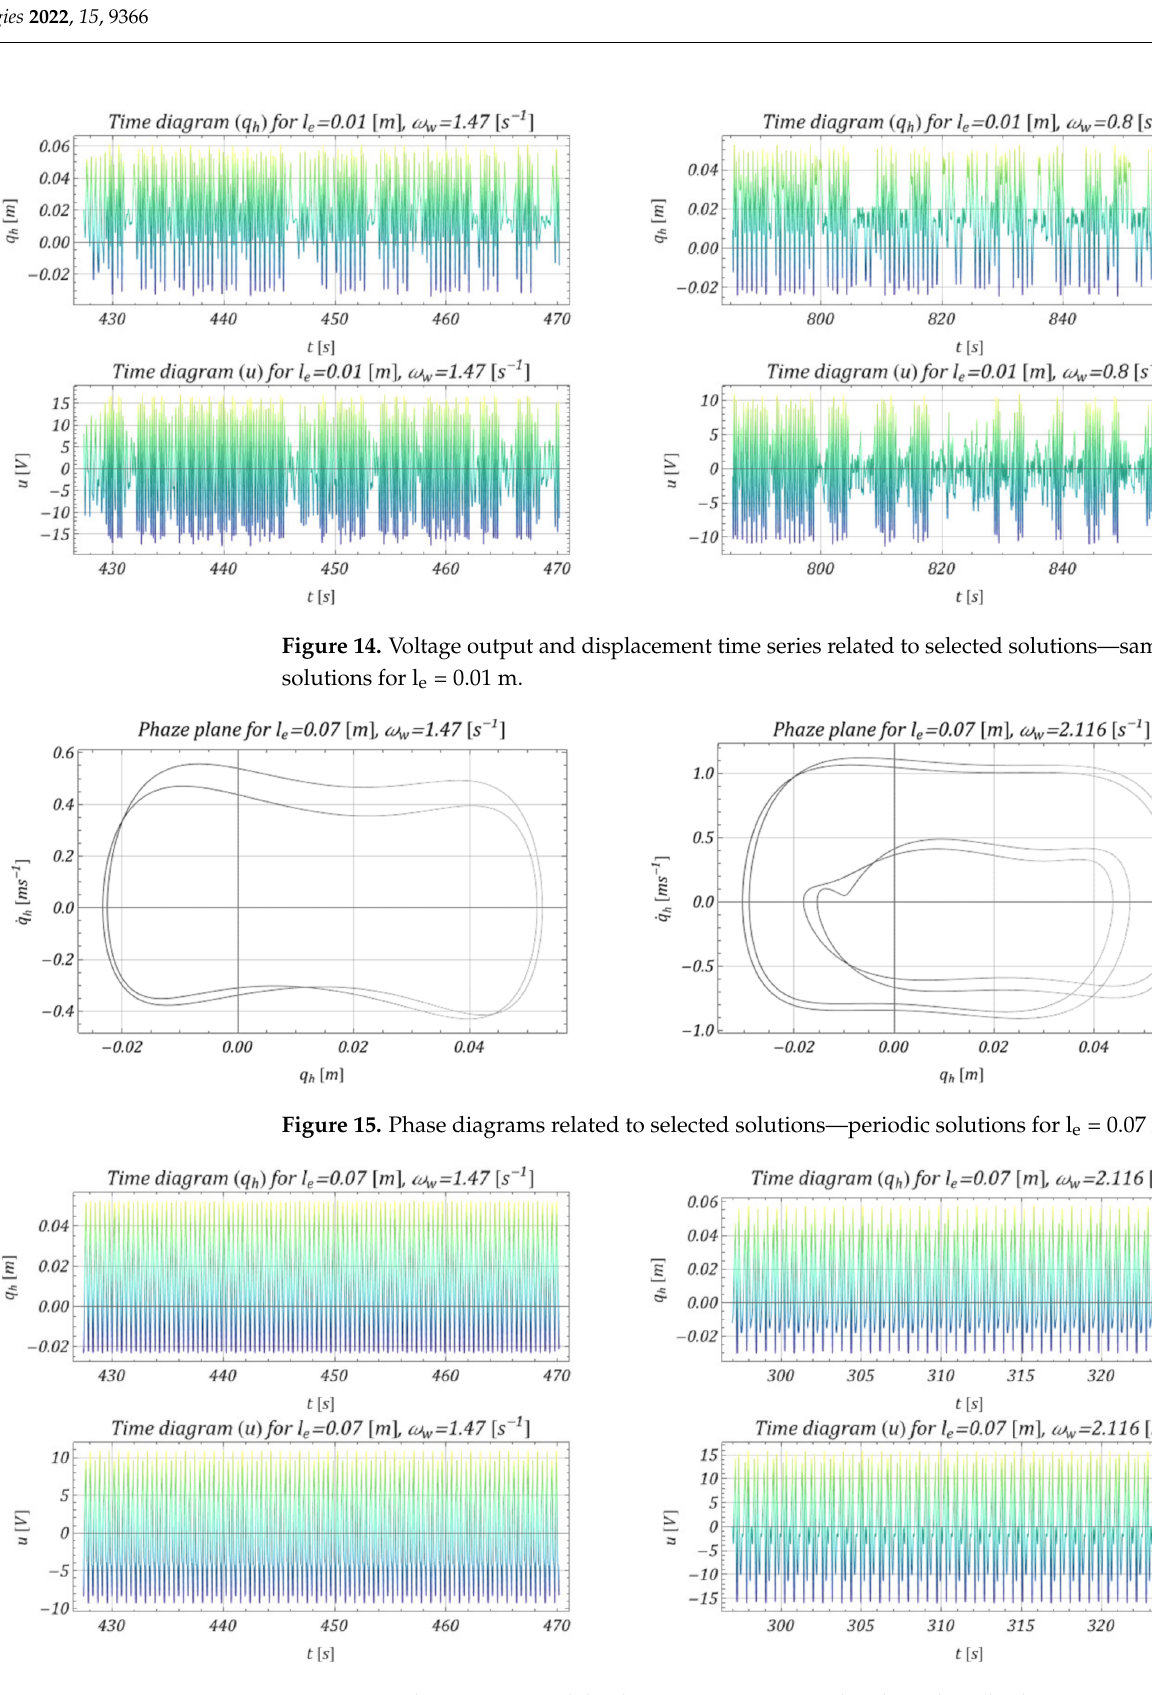
Figure 16. Voltage output and displacement time series related to selected solutions—sample periodic solutions for l e = 0.07